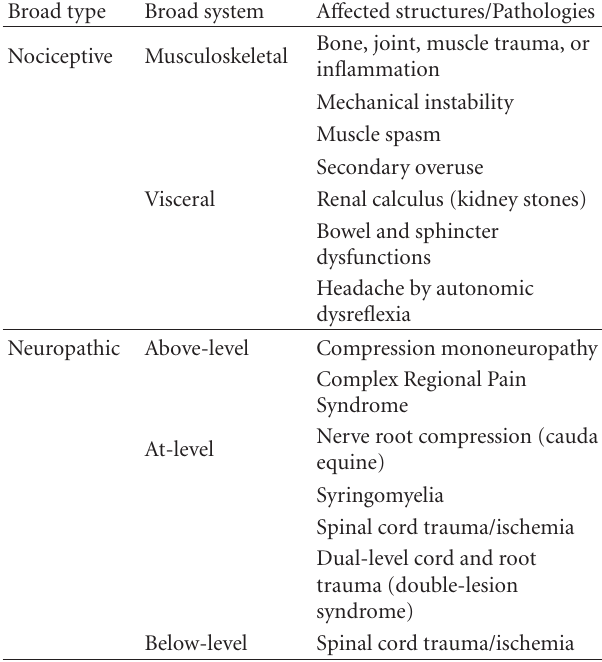
Table 1: Classification of the Spinal Cord Injury Pain Task Force of the International Association of the Study of Pain.